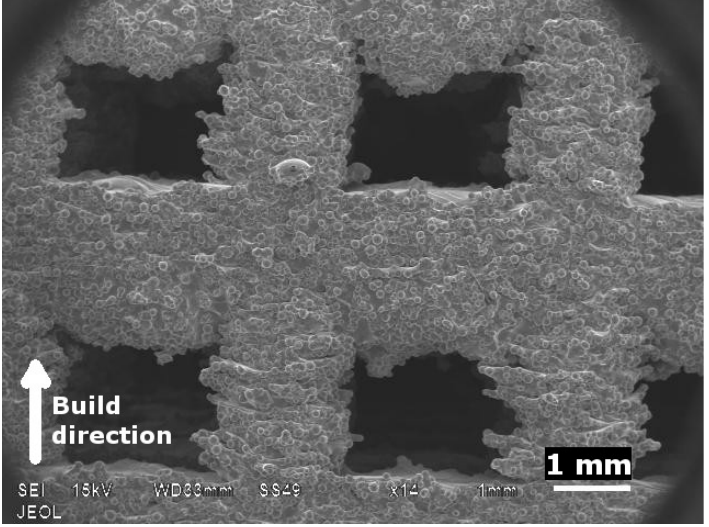
Figure 8. SEM image showing jagged vertical struts produced using standard scan strategy (1.5 mm strut).